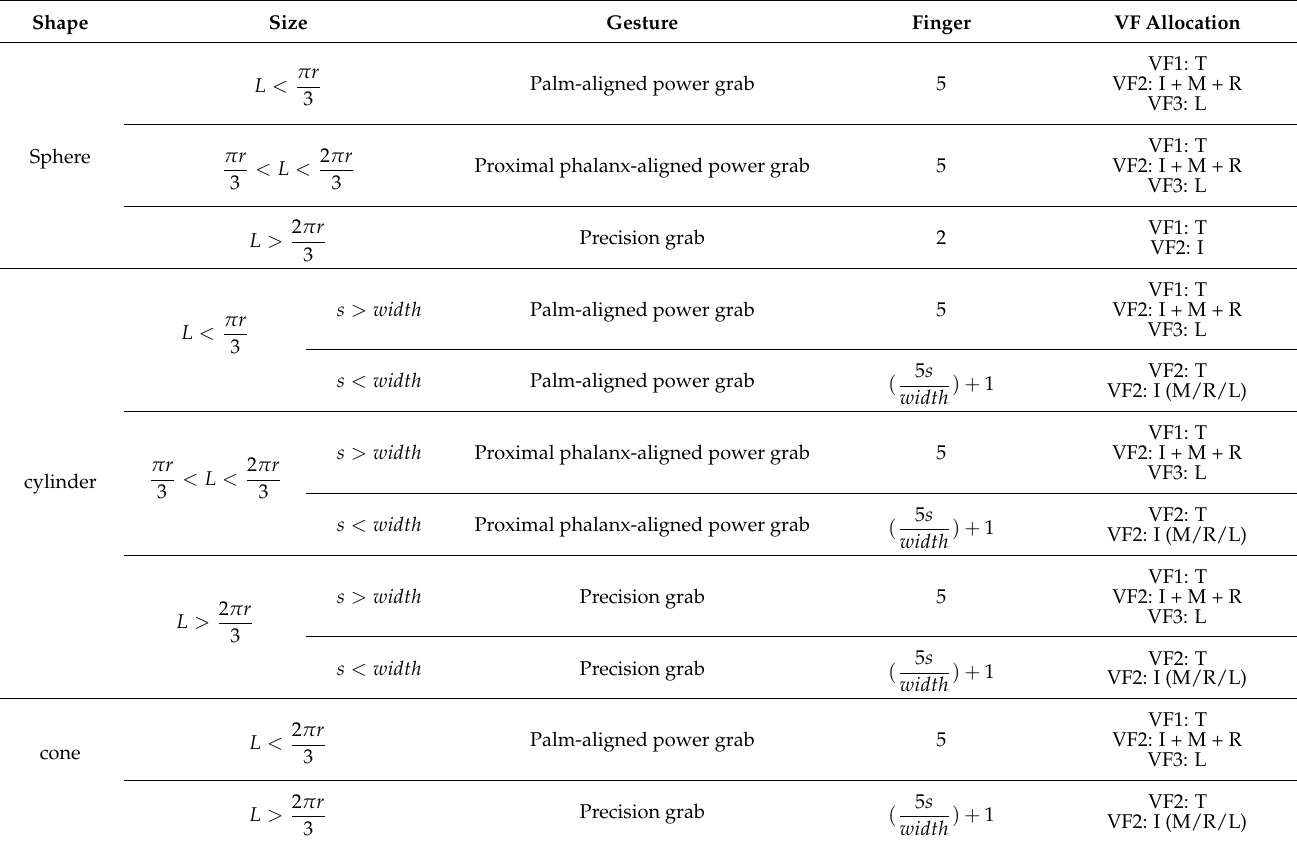
Table 1. The summary of grasping posture library based on human